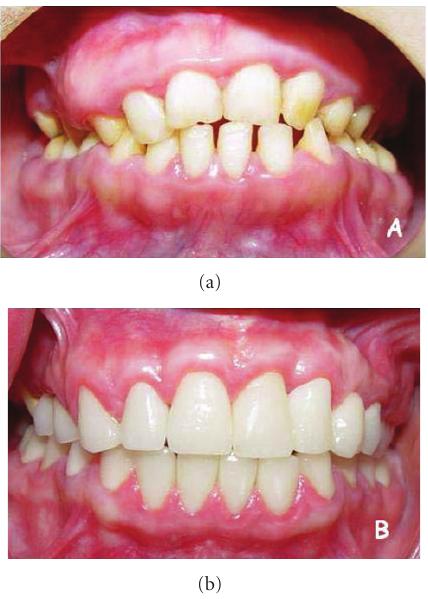
Figure 5: Preoperative (a) and the final (b) intra oral appearances of 19-year-old patient at the 3rd